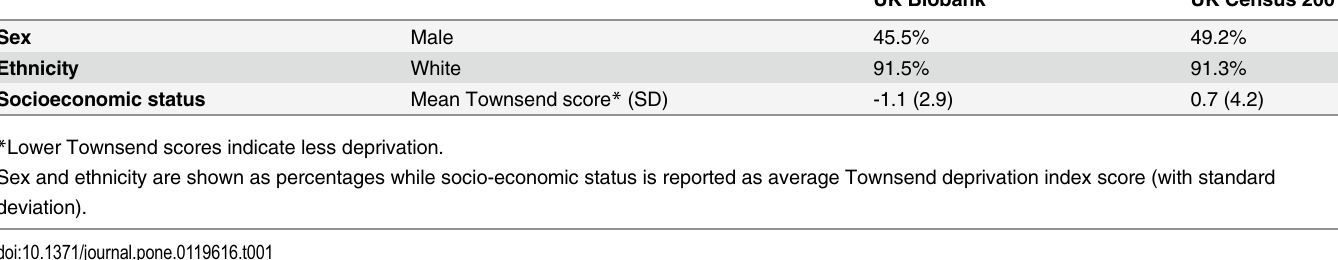
Table 1. Participants in the study sample versus 2001 UK Census data for sex, ethnicity and socio-economic status.